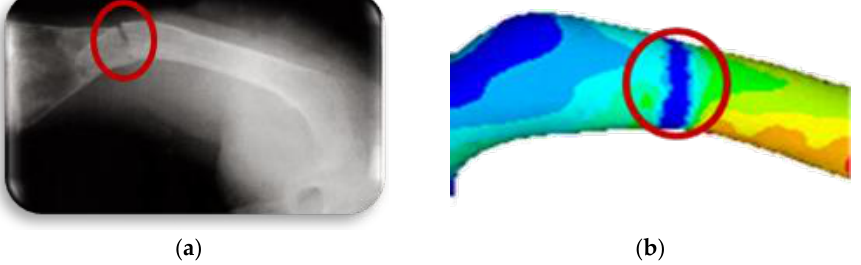
Figure 12. Transverse fracture: ( a ) medical image of bone fracture; ( b ) fracture of finite elements generated on the